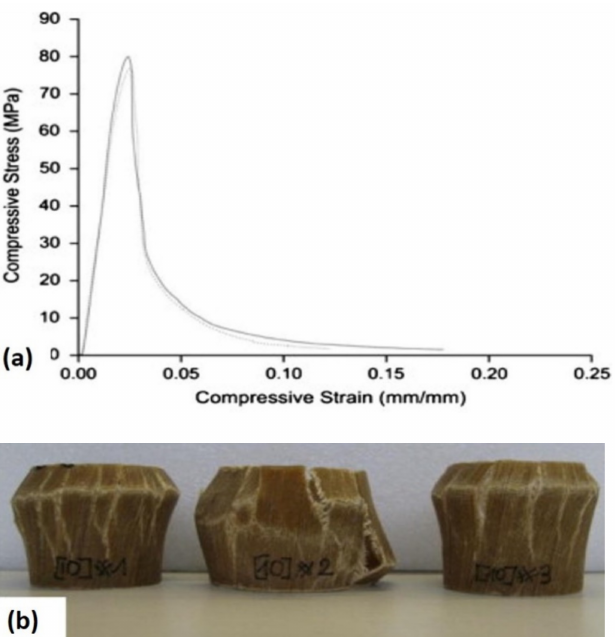
Figure 6. Micro-buckling fracture of a natural fiber composite consisting of hemp yarns with 10 ◦ orientation; ( a ) Stress–strain response graph and ( b ) Example of sample fractures in micro-buckling. Adapted from ref.